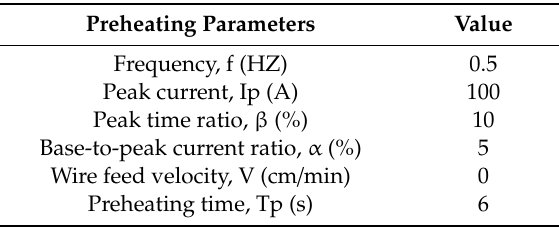
Table 2. Parameters of preheating.